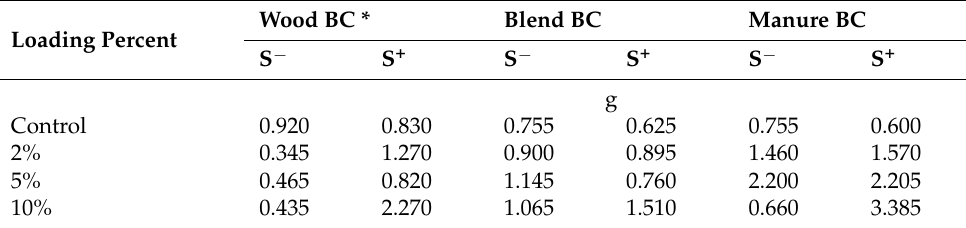
Table 8. Lolium multiflorum herbage dry weight (g) medians according to saturation and loading percent.